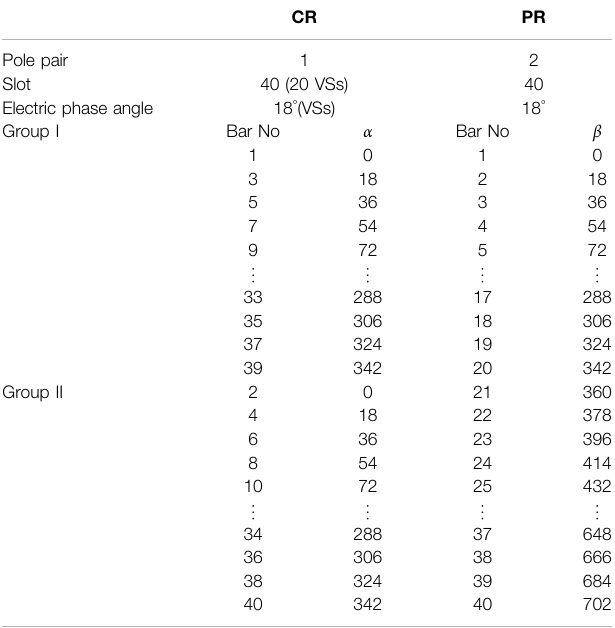
TABLE 3 | Interconnection between PR and CR bars under PW with 2 pole pairs, CW with 1 pole pairs and rotor slots of 40. CR PR Pole pair